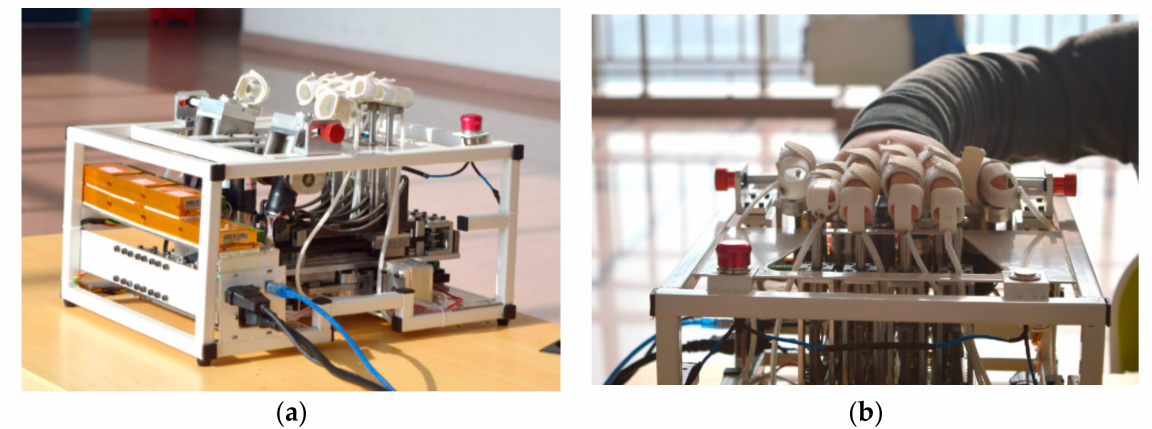
Figure 13. ( a ) Prototype of the EFRR; ( b ) scenes of volunteers wearing EFRR for